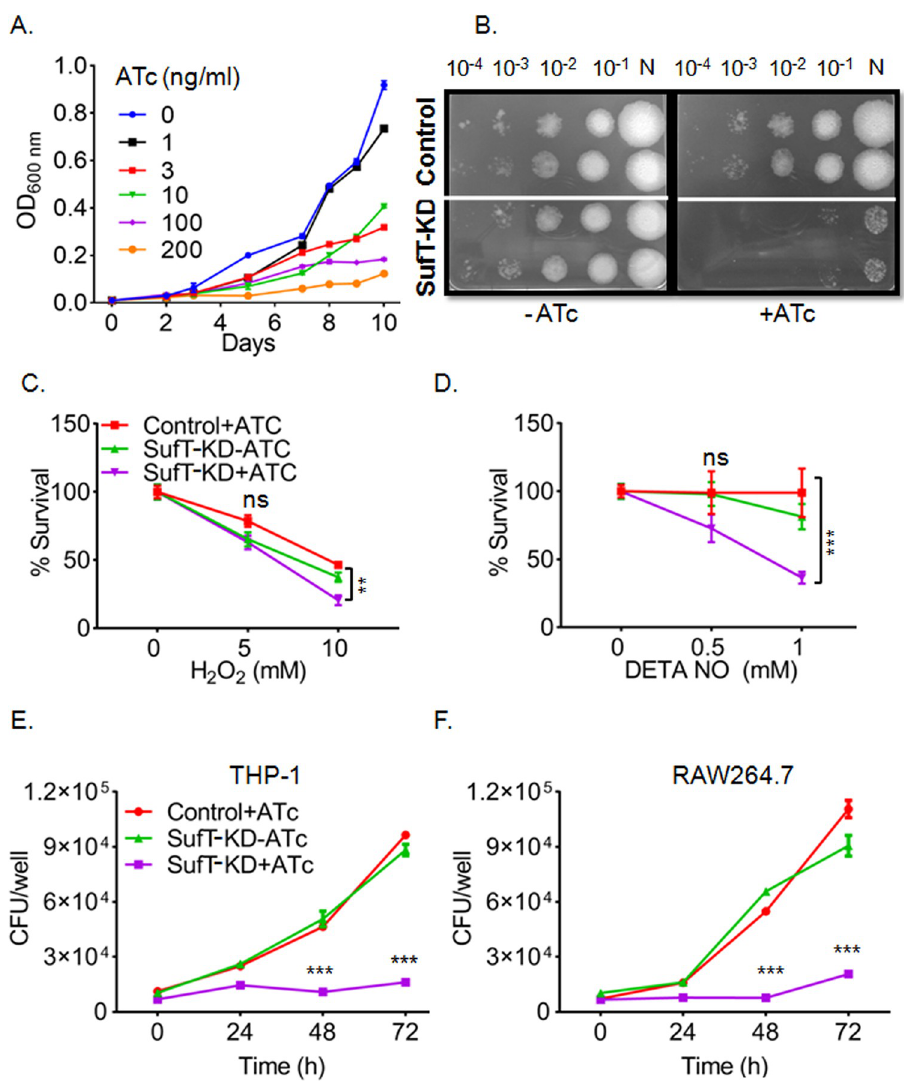
standard liquid 7H9 medium. (B) Image of the serially diluted (N = undiluted) culture spotting of control as well as SufT-KD on 7H11 plates with and without ATc (200 ng/mL). Log phase culture of control +ATc, SufT-KD+ATc and– ATc were diluted to 0.15 OD (~2x 10 7 cells/mL) and treated with (C) H 2 O 2 (0 mM, 5 mM and 10 mM) or (D) DETA NO (0 mM, 0.5 mM and 1 mM) for 12 h. Ex vivo survival of control +ATc, SufT-KD +ATc, and–ATc was performed in (E) THP-1 and (F) RAW264.7 cell line. Infection was performed at MOI: 2 for 4 h (0 h). CFU was measured at 0, 24, 48 and 72 h of infection. Experiments were performed in triplicate with two independent experiments.